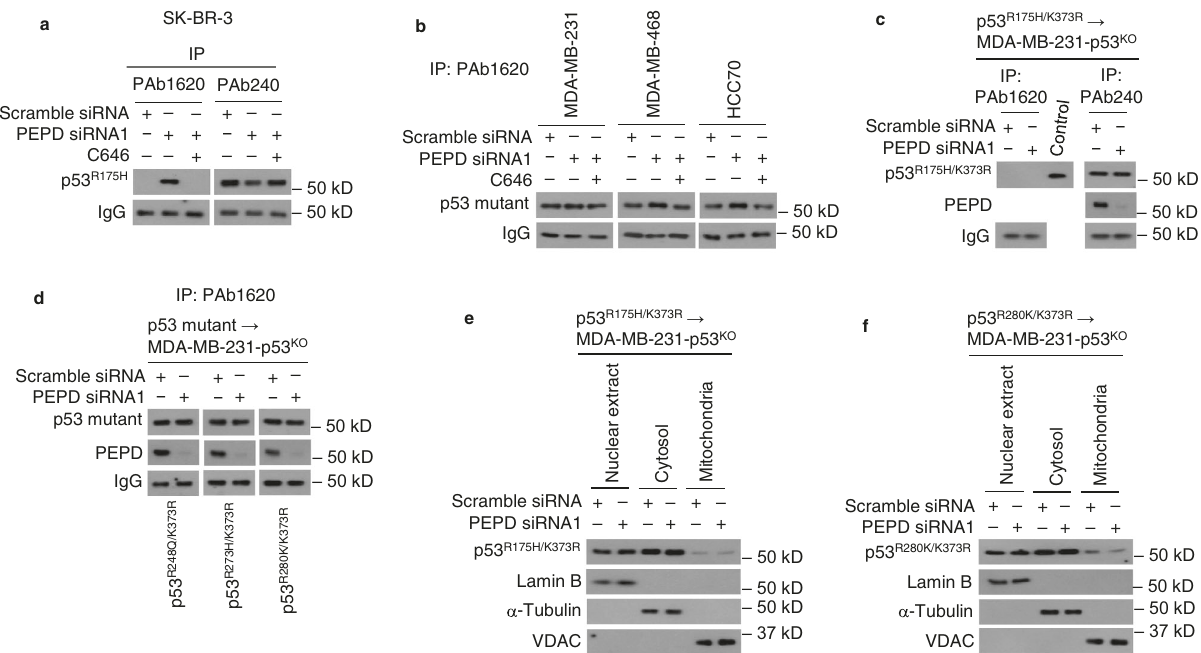
Fig. 9 K373 acetylation is required for refolding and mitochondrial enrichment of p53 mutants freed from PEPD. a , b Cells were treated by siRNA (10 nM) for 48 h with or without C646 (8 μ M). WCL was subjected to IP by PAb1620 or PAb240, followed by WB analysis of the precipitate for p53 mutants. c, d MDA-MD-231 (p53 KO ) cells were transfected with p53 R175H/K373R, p53 R248Q/K373R , p53 R273H/K373R , or p53 R280K/K373R and 24 h later treated with siRNA (10 nM) for 48 h. WCL was subjected to IP by PAb1620 or PAb240, followed by WB analysis of the precipitate by p53 mutants and PEPD. A p53-containing sample (WCL of untreated CAL-51 cells) was used as positive control during WB in c . e , f MDA-MD-231 (p53 KO ) cells were transfected with p53 R175H/K373R or p53 R280K/K373R and 24 h later treated with siRNA (10 nM) for 48 h. p53 mutants in subcellular fractions was analyzed by WB. Lamin B, α -tubulin and VDAC were measured as loading controls and for ruling out cross